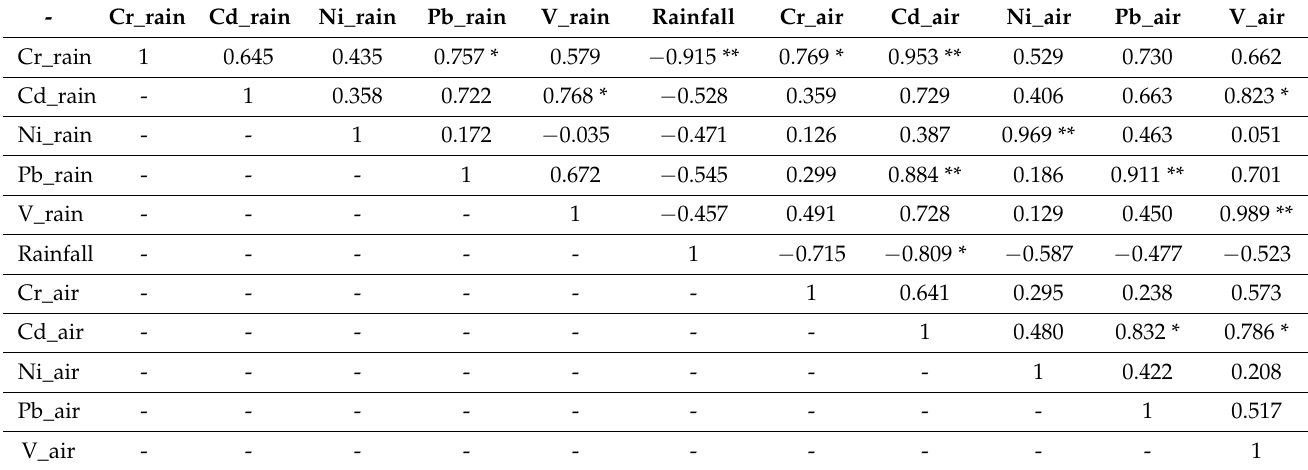
Table 4. Correlation matrix of the tested variables: correlation is significant at the 0.05 level (*) and at 0.01 level (**)